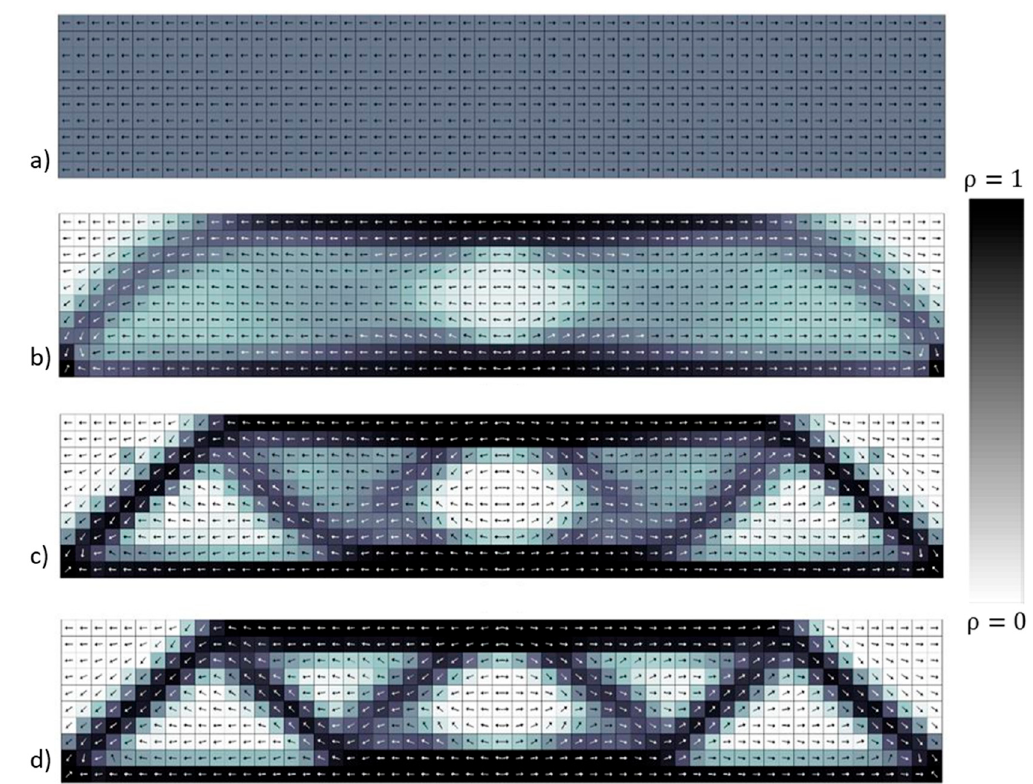
Figure 4. CFAO density and fiber angle results for the MBB beam after ( a ) 0 iterations (i.e., initial design), ( b ) five iterations, ( c ) 25 iterations, and ( d ) final iteration 48. Elements with density approaching unity appear dark, while those appearing white indicate zero density.